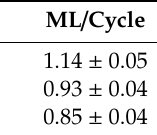
Table 1. Average deposition charge ( Q ) and coverage of UPD-Mn integrated from the curves shown in Figure 3.